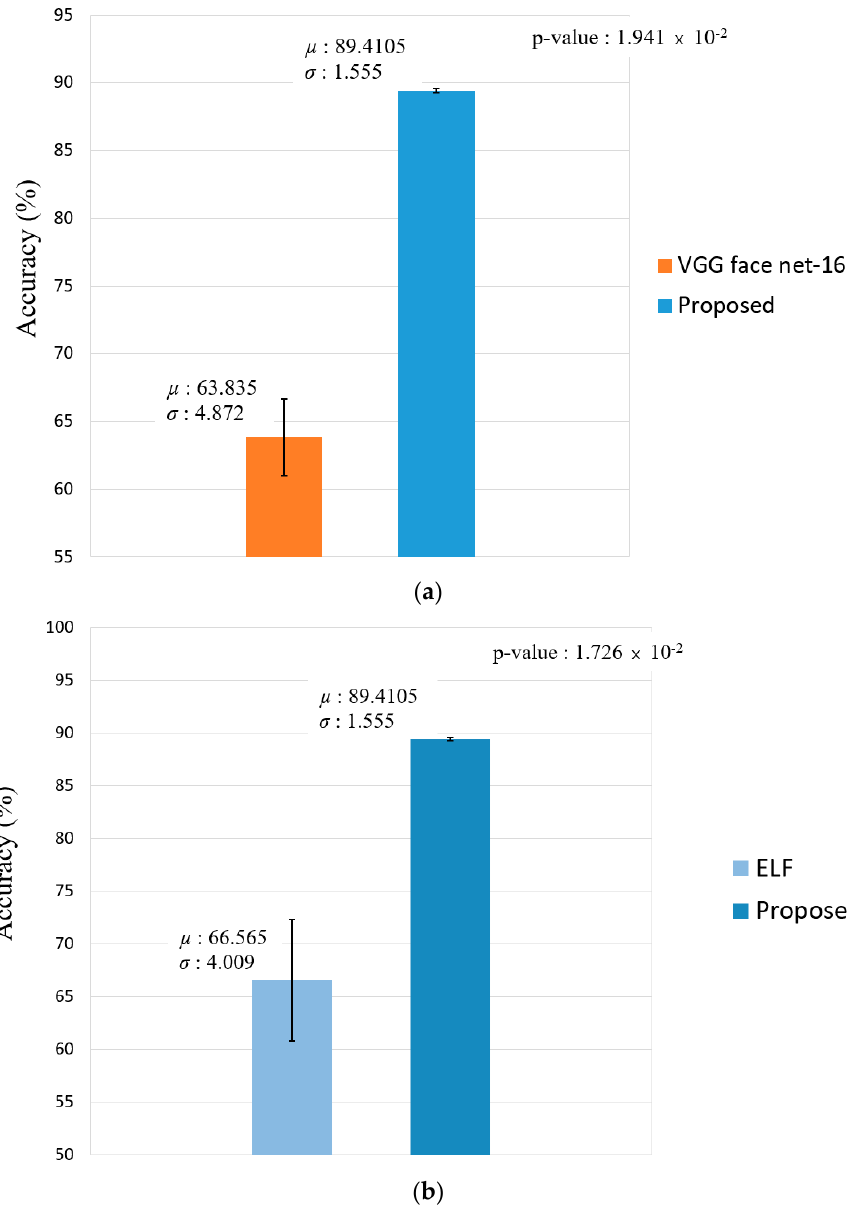
Figure 19. Graphs for t-test result of the second best model and our proposed method with regard to average recognition accuracy. ( a ) Comparison of VGG face net-16 [44] and the proposed method, and ( b ) comparison of the proposed method and ELF [48].